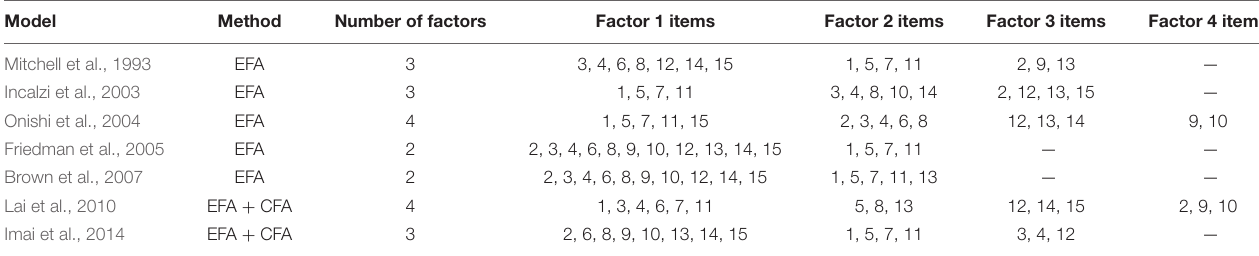
TABLE 1 | Characteristics of each factor model tested.